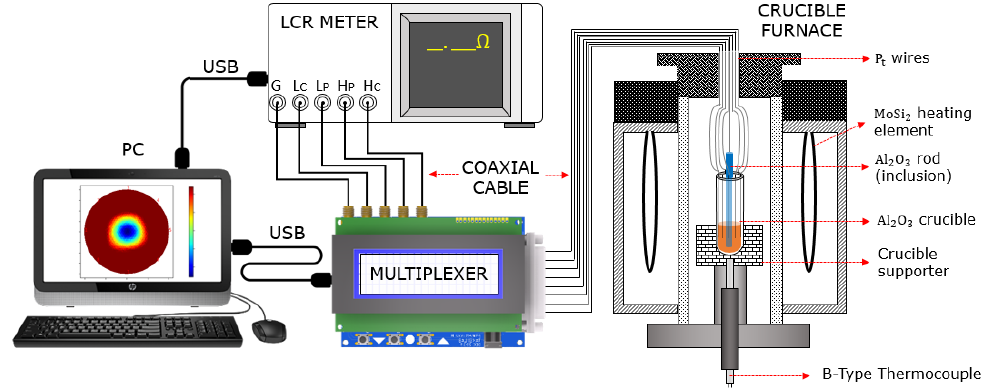
Figure 4. Experimental setup schematic.